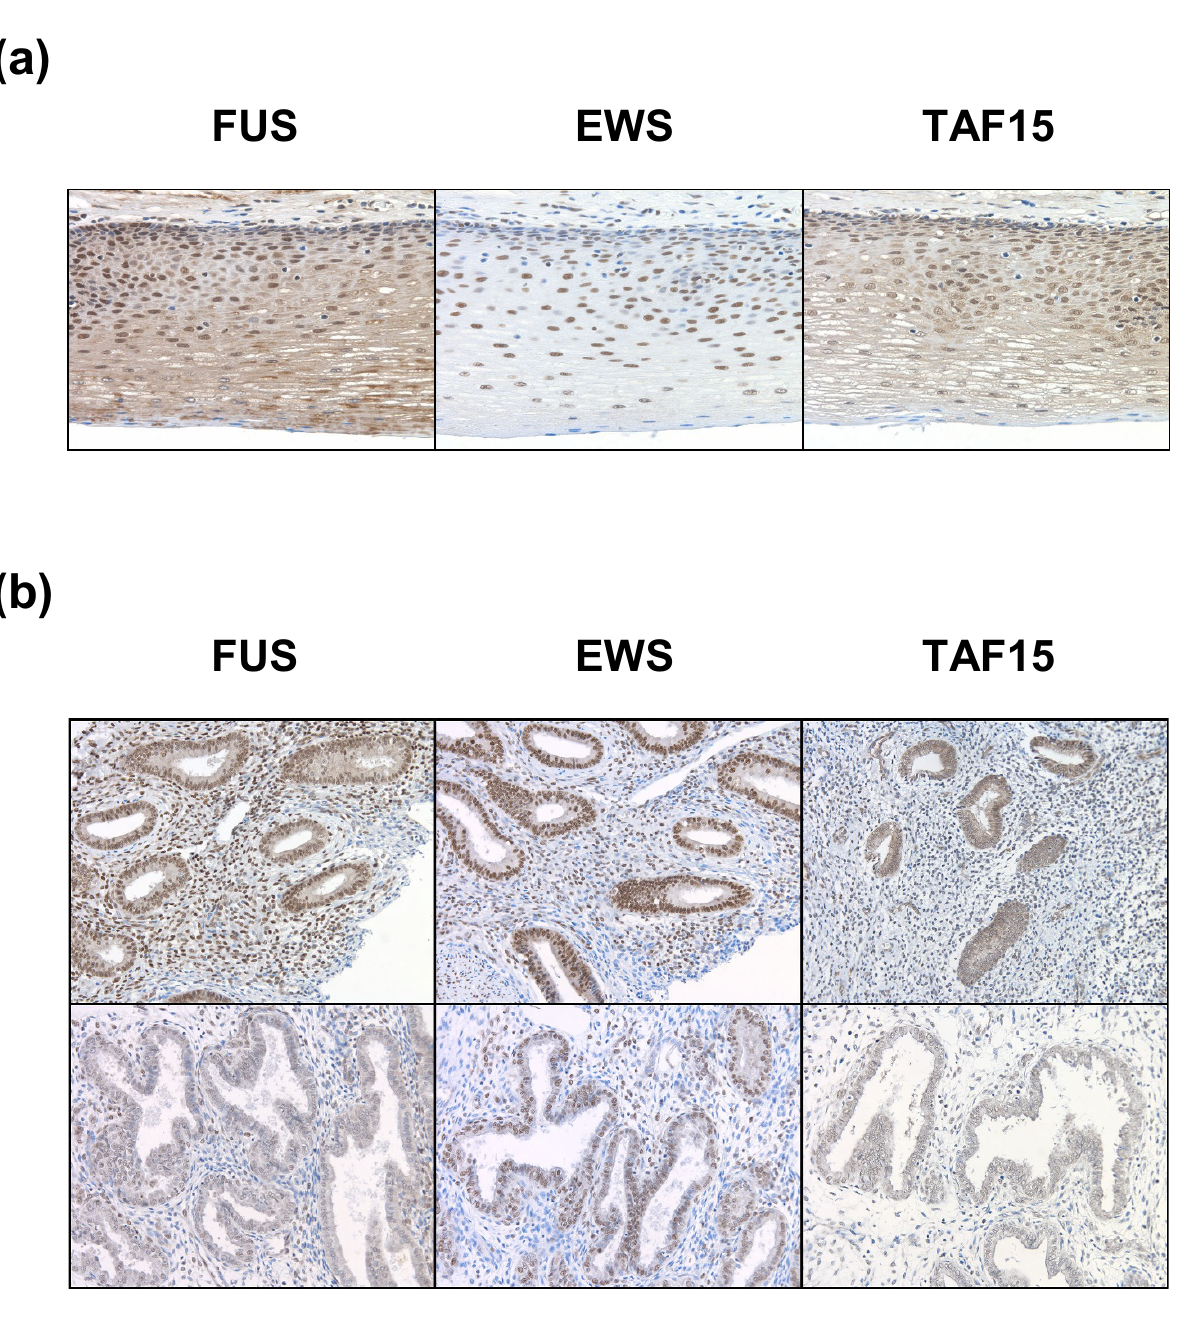
Figure 5 Heterogenous FET protein expression in human tissues . Brown staining indicates FET expression while blue staining shows negatively staining nuclei. (a) Individual epithelial cells of esophagus show large heterogeneity in FET expression levels. (b) FET expression is elevated in proliferating endometrium (upper panel) compared to differentiated secretory endometrium (lower